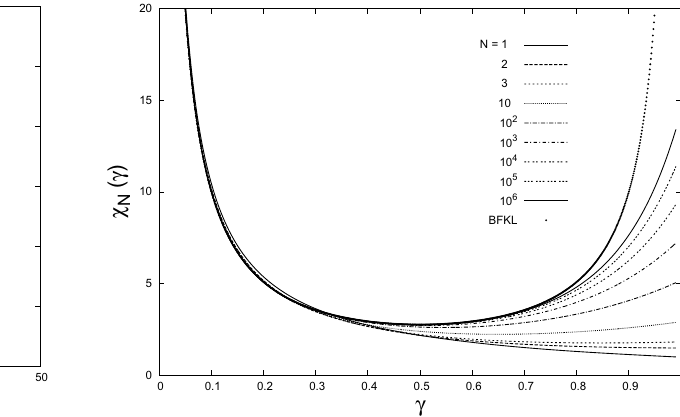
N 0 = δ i (cid:13) taking N 0 = 3 for (cid:13) = 1 i